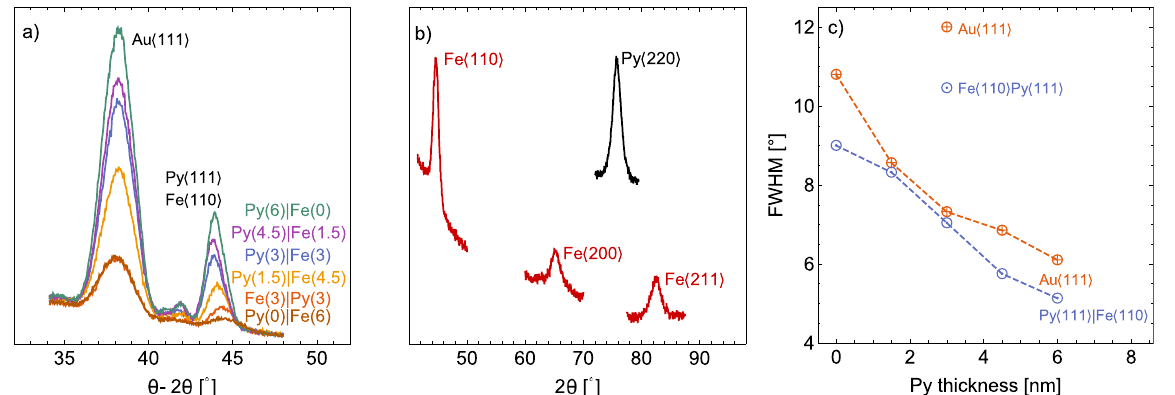
Figure 1. ( a ) Out-of-plane XRD θ − 2 θ scan for Py|Fe and Fe|Py bilayers deposited on Ta and capped with Au. Layer thickness in nm are labeled in parenthesis. The peak at 38.1° is from 〈 111 〉 Au protective layer and the peak between 44.0–44.4° is from both 〈 111 〉 Py (bulk at 44.0°) and 〈 110 〉 Fe (bulk at 44.4°). ( b ) In-plane XRD at 0.5° grazing incidence angle of . dashed lines are guide for the eye. The two outlier points correspond to the